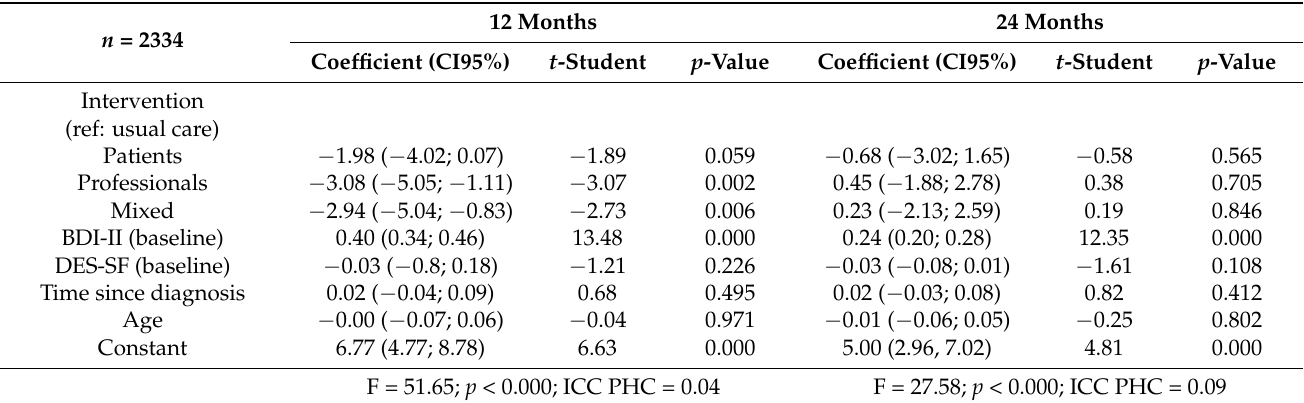
Table 4. Regression model for depressive symptoms (BDI-II) after 12 and 24